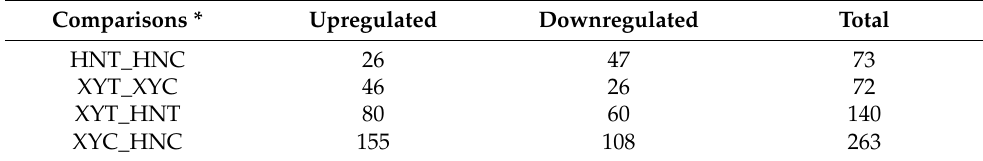
Table 1. Number of DAPs identified in each comparison group.